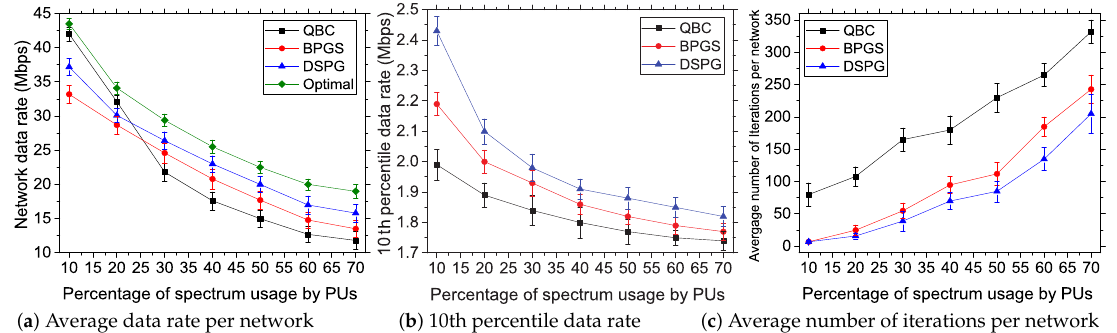
Figure 7. Impact of PU density on the performance of the studied resource allocation